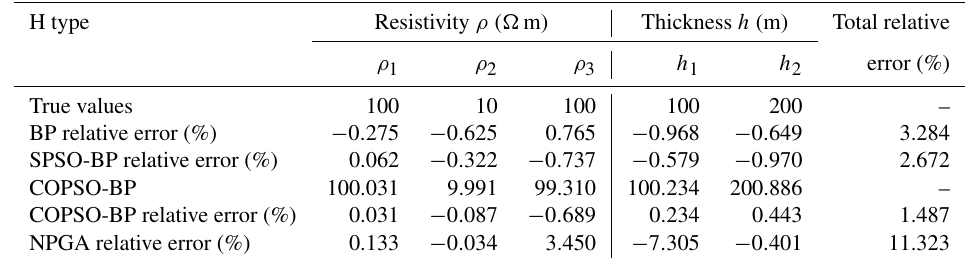
Table 3. Inversion comparison of three-layer H-type geoelectric models.